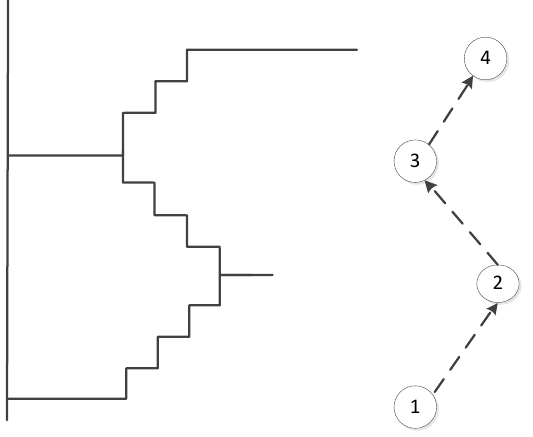
Figure 6. An example of using OSM relations to model stairs. The stair relation here consists of four members (i.e., Step 1, Step 2, Step 3, Step